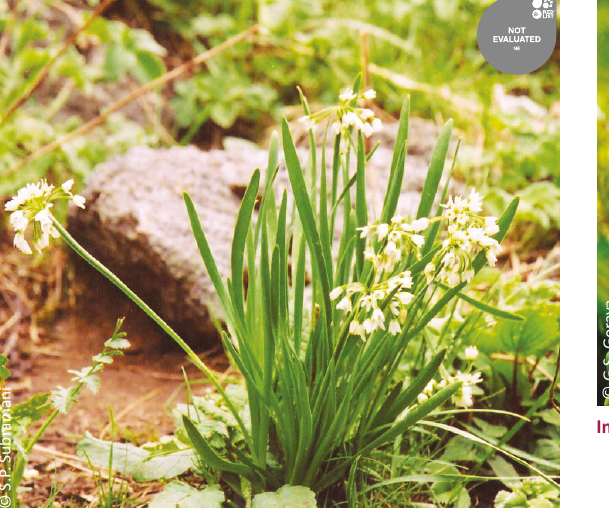
Image 27. Allium humile Kunth